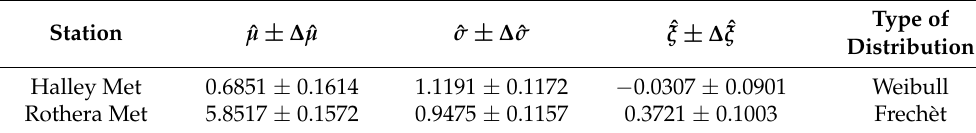
Table 2. Values of the three parameters, with their errors, obtained from the maximum-likelihood estimation method for maximum temperature events. The distribution type is also indicated. Station